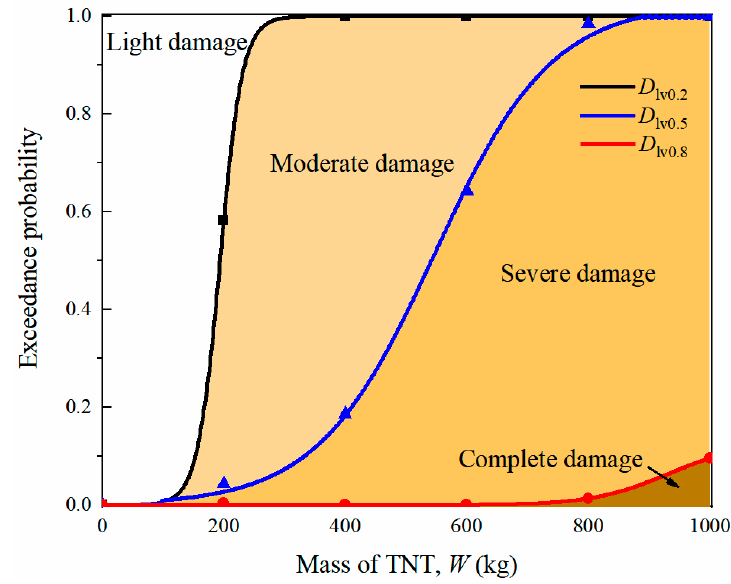
Figure 17. Vulnerability diagram of the prototype of tunnel entrance.